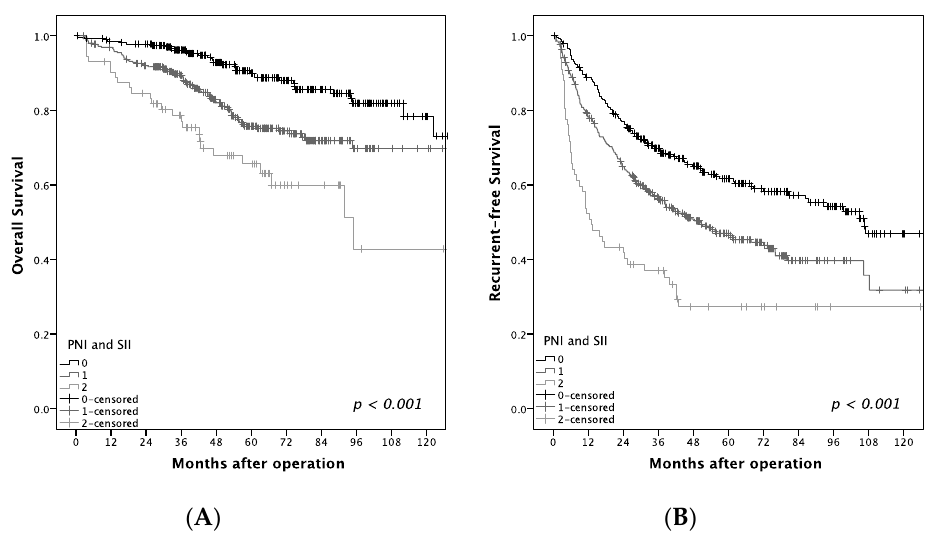
Figure 4. Relationship of prognostic nutrition index (PNI) and systemic Immune-Inflammation Index (SII) to ( A ) overall survival (OS) and ( B ) recurrence-free survival. Group 0 = PNI > 45 and SII > 160, group 1 = PNI > 45/SII ≤ 160 or PNI ≤ 45/SII > 160, group 2 = PNI ≤ 45 and SII ≤ 160.